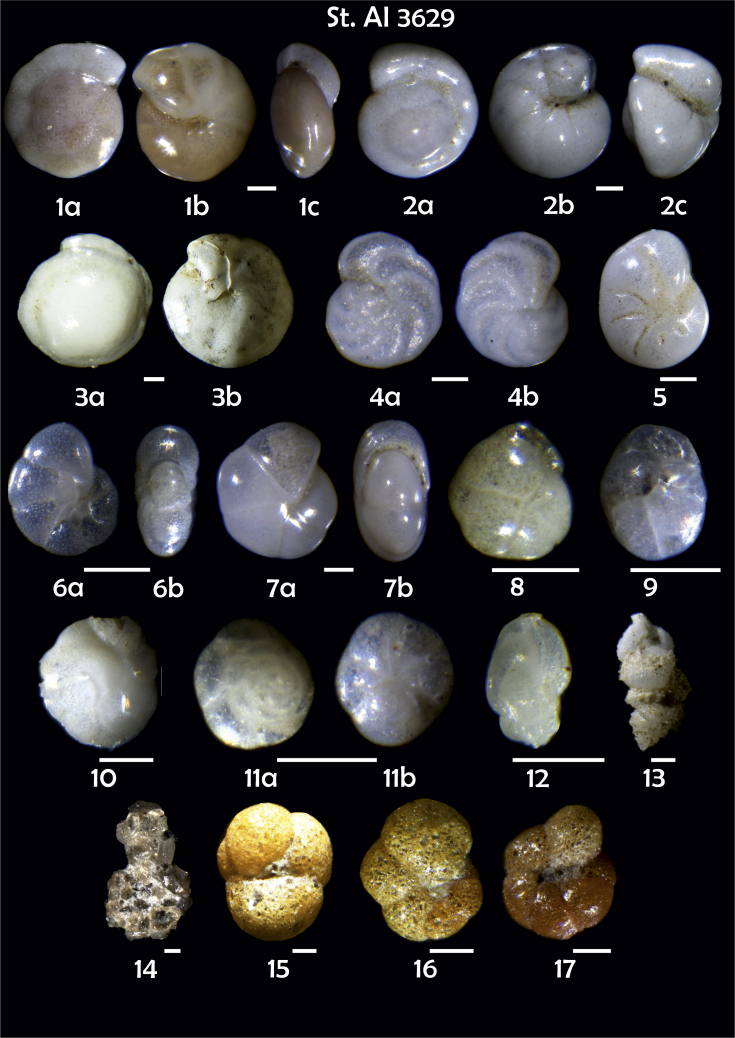
Station 36291Gyroidina orbicularis, a spiral view, b umbilical view, c apertural view. 2Hansenisca soldanii,a spiral view, b umbilical view, c apertural view. 3Oridorsalis sp., a spiral view, b umbilical view. 4Cibicidoides wuellerstorfi, a umbilical view, b spiral view. 5Elphidium incertum?. 6Astrononion stelligerum, a side view, b apertural view.7Pullenia quinqueloba,a side view, b apertural view. 8Cassidulina reniforme.9Globocassidulina subglobosa. 10Cassidulina laevigata. 11Alabaminella weddellensis, a spiral view, b umbilical view. 12Trifarina angulosa. 13Uvigerina aculeata. 14 ?. 15 ?. 16Trochammina inflata. 17 ?. Scale 100 μm.